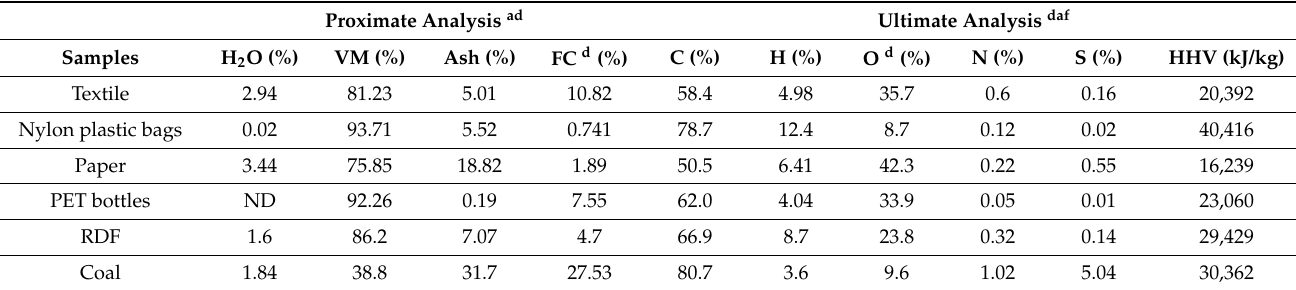
Table 1. Proximate & ultimate analysis of selected samples